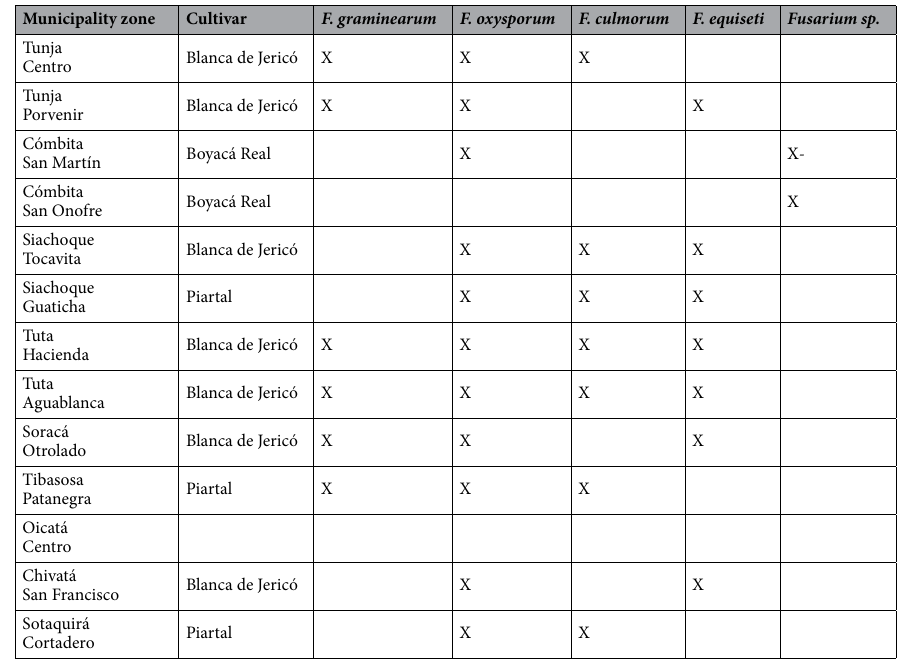
Table 1. Presence of Fusarium spp. in the study